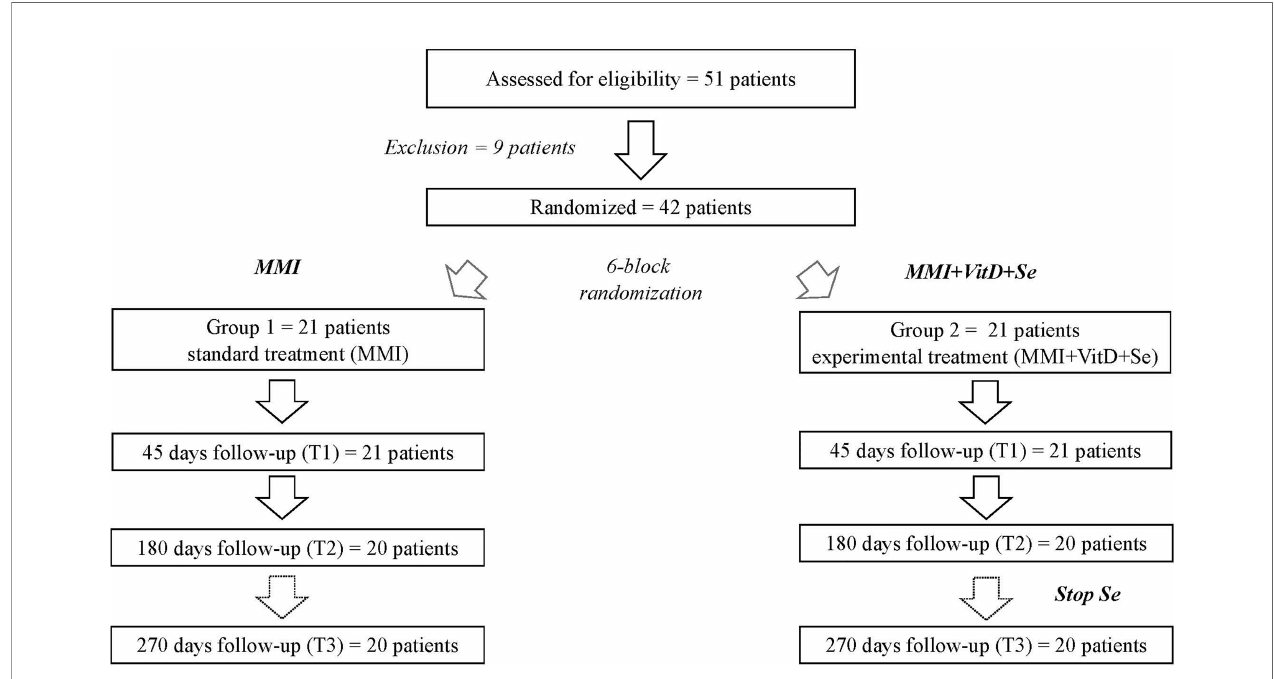
FIGURE 1 | Flow-chart describing the design of the